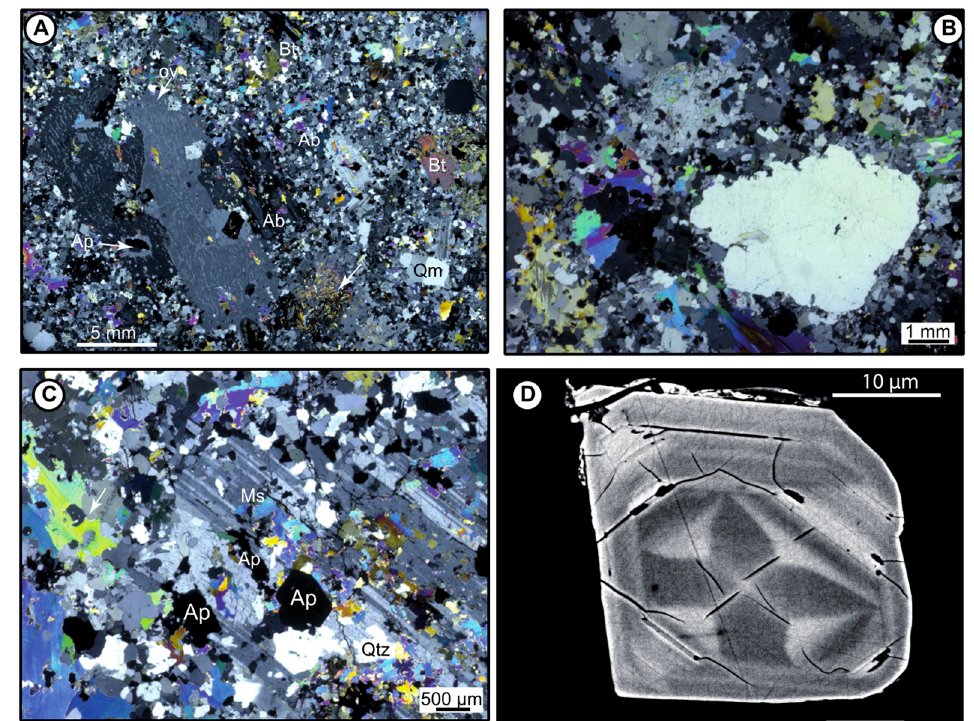
Figure 11. G1 granite unit from the SCB2 drill hole. ( A ) Photomicrograph global view of the two mica G1 texture (cross-polarized light, sample PAN-16-5a). Megacrysts (Kfs, Ab, Bt, quartz Qm) are embedded in a fine-grained matrix. Note the perthites in the Kfs and the broad albite rim around the apatite (Ap), included in the Kfs. A rim devoid of perthites (OV) is noticeable in the Kfs. Note also the muscovite canvas in some albite megacrysts (arrow). ( B ) Detail of magmatic quartz in G1, showing lace-shaped overgrowths (r) (microphotograph in cross-polarized light, sample PAN-16-6). Note the amoeboid shape of muscovite crystals. ( C ) Development of patchy quartz (Qtz), muscovite (Ms), and apatite (Ap) in a G1 albite megacryst. Note the independency between quartz and muscovite. The large muscovite flakes display amoeboid shapes (arrow) (microphotograph in cross-polarized light, sample PAN-16-6). ( D ) SEM-BSE image of zoned zircon included in G1 biotite. Note the spectacular sector zoning. Variations in Hf contents mainly control the compositional zoning pattern.